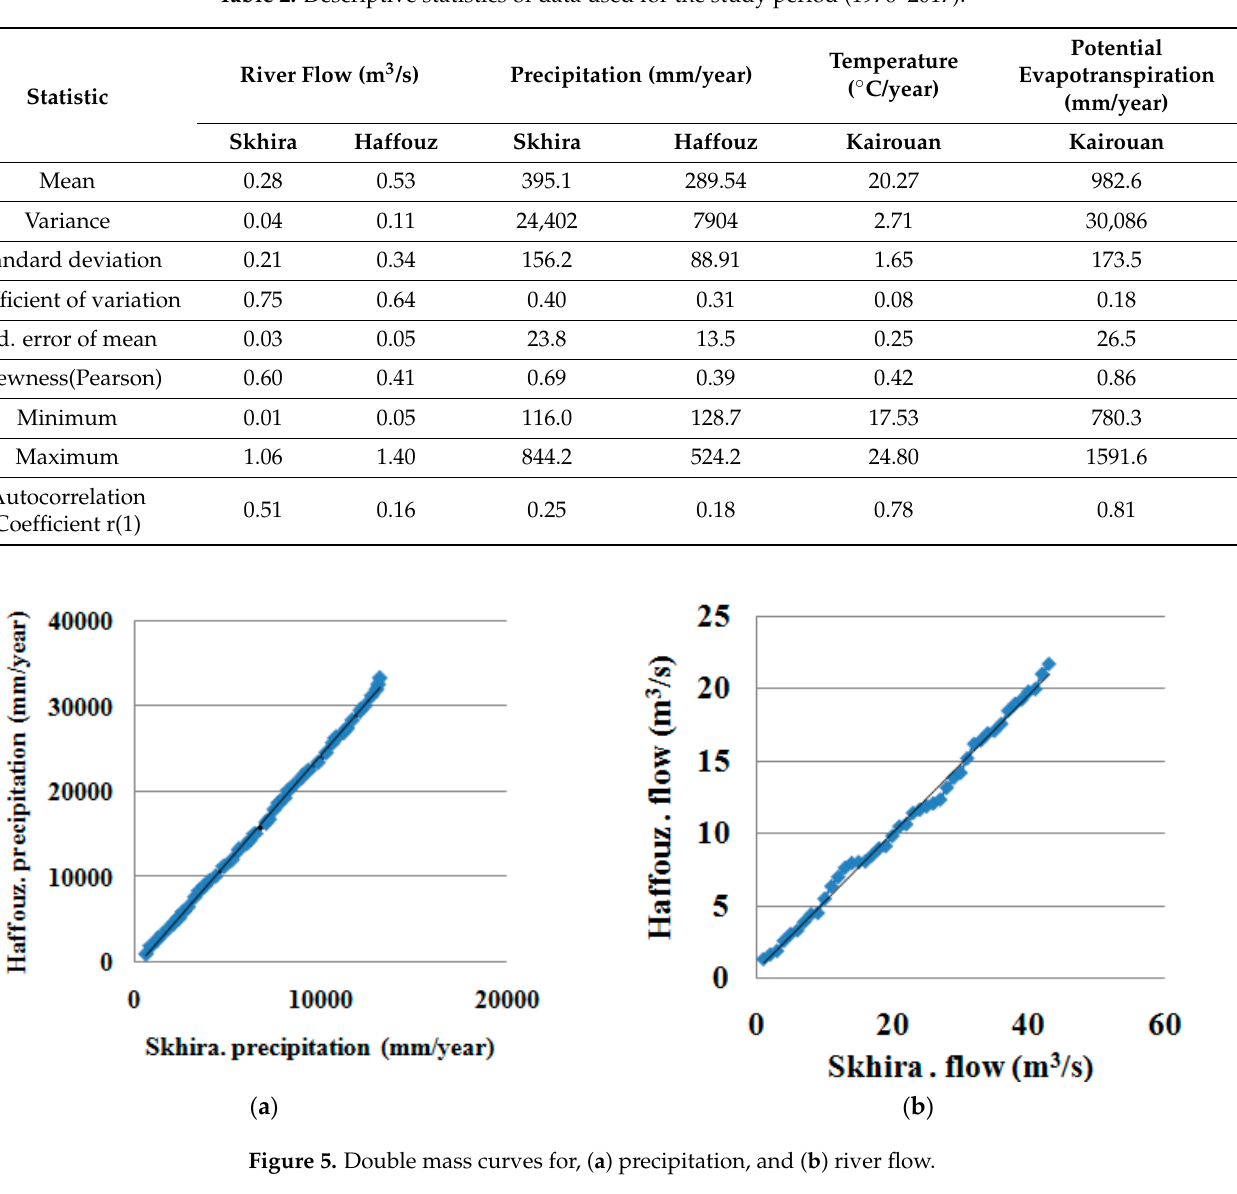
Table 1. Characteristics of stations used.